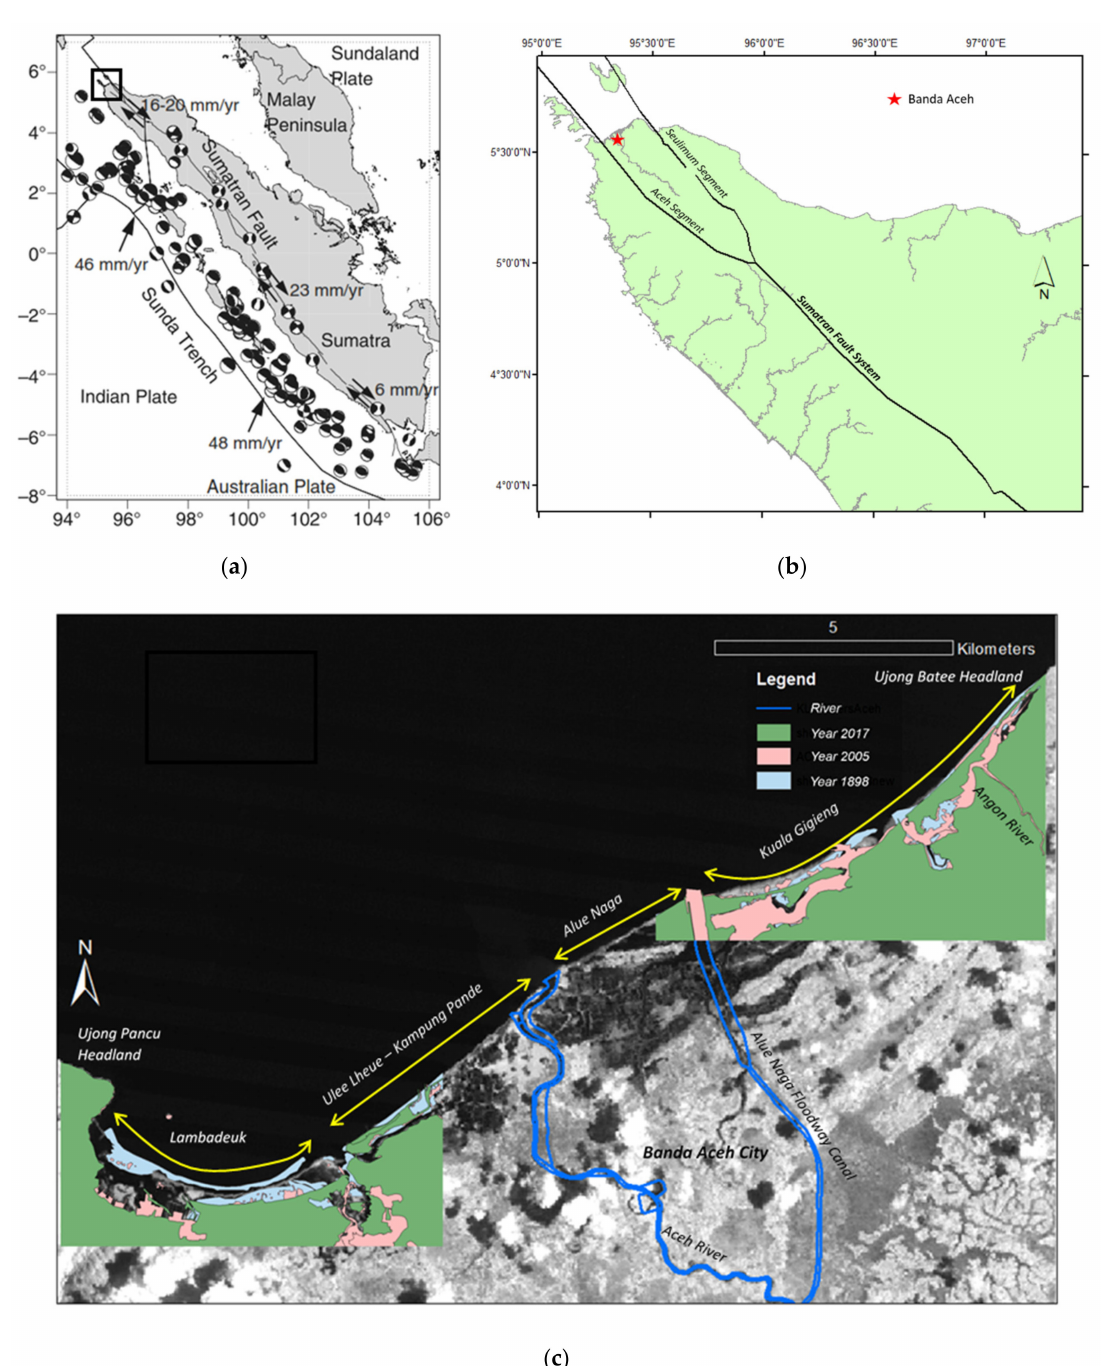
Figure 1. Banda Aceh coast, at the northern tip of Sumatra Island, Indonesia: ( a ) Tectonic settings of Sumatra, compiled from various sources by Hurukawa et al. [43], showing the configuration of the Sumatran fault, slip rates, the plot of Global Centroid Moment tensor (CMT) solutions of shallow earthquakes (M w ≥ 6.0 and depth ≤ 60 km) between 1976 and 2012; ( b ) Segments of the Great Sumatran Fault System at the northern Sumatra consists of two bifurcated fault segments, i.e., Aceh Segment and Seulimum Segment. The rectangle shows the investigated coastal area in front of Banda Aceh, the capital of Aceh Province, which is situated between the two fault segments; ( c ) The two investigated coastal sections in this study are Lambadeuk at the southwest and Kuala Gigieng at the northeast since they are the most dynamic and there is less interference by hard-structure coastal